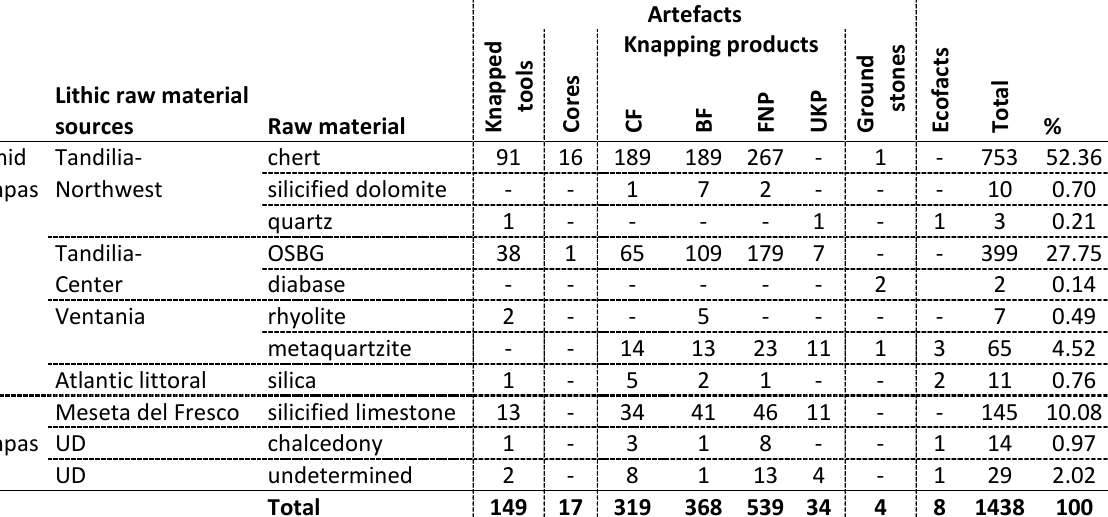
Table 2. Provenance of the lithic raw materials and assemblage composition of Hangar. Abbreviations: OSBG = Orthoquartzite SBG; CP = Complete Flake; BF = Broken Flake; FNP = flake with no platform; UKP = undetermined knapping product; UD = undetermined;